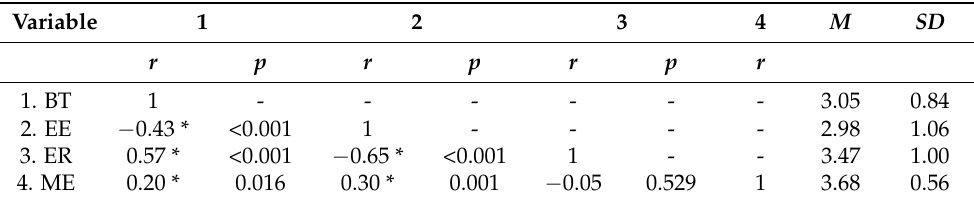
Figure 2. Path analysis results for facets of intuitive exercise before the pandemic predicting exercise behaviors and attitudes during the pandemic. Note. The first indicator for each latent variable served as the scaling indicator, represented with a “1”. No paths were significant. In this model, latent variables represented intuitive exercise before the pandemic, whereas outcomes represented exercise attitudes and behaviors during the pandemic. Table 2. Correlations between Before COVID-19 Intuitive Exercise Latent Variables.